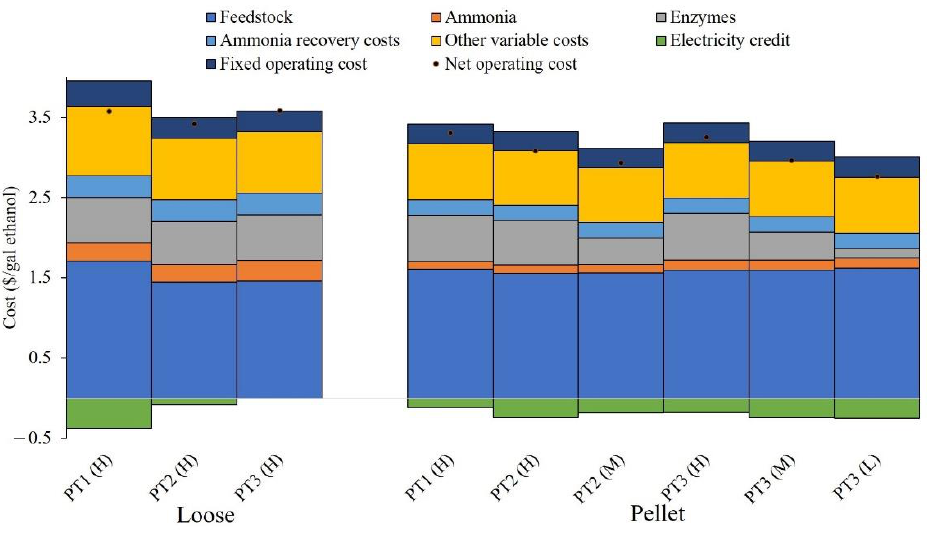
Figure 3. Breakdown of operating costs (variable and fixed) for loose and pelleted forms of biomass under different pretreatment conditions (PT1: 45 °C, 9 h, 12% ammonia; PT2: 50 °C, 14 h, 14% ammonia; PT3: 55 °C, 19 h, 16% ammonia) and enzyme loadings (high for loose biomass, and low, medium, high for pelleted biomass).